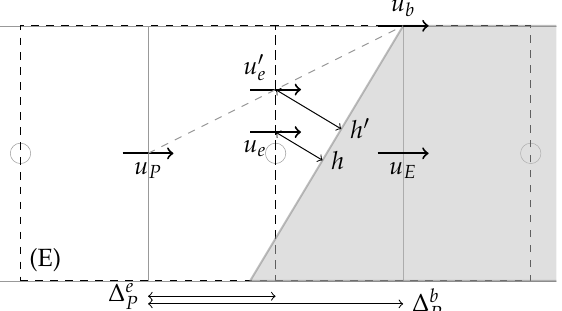
Figure 6. Limit case of interpolation for u e near solid boundary in which A u e is cut, u E is within the solid and A p e = 0.